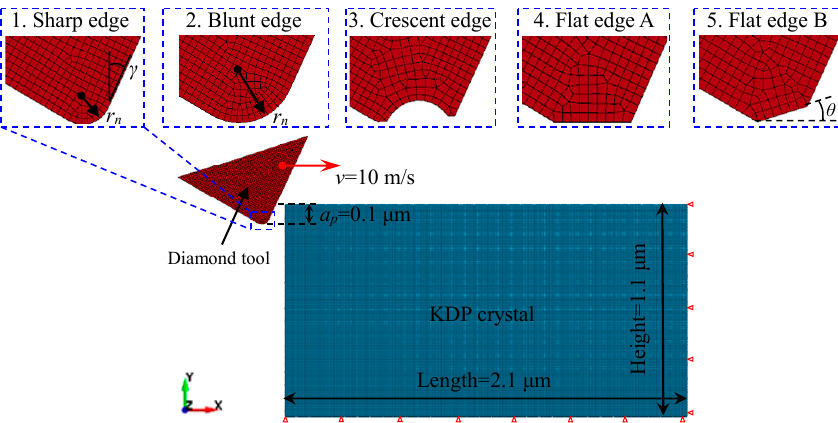
Figure 4. SPH cutting models with different tool-edge micro defects (including sharp edge, blunt edge, crescent edge, flat edge A, and flat edge B).